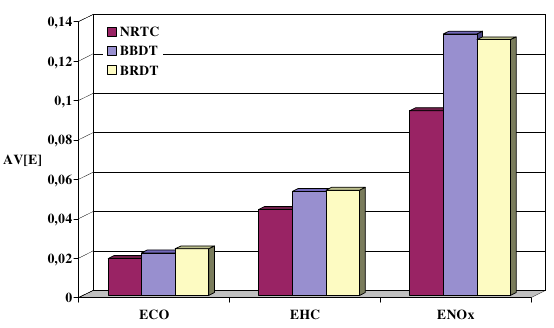
Fig. 14. The average value – AV[E] of pollutant emission intensity in individual